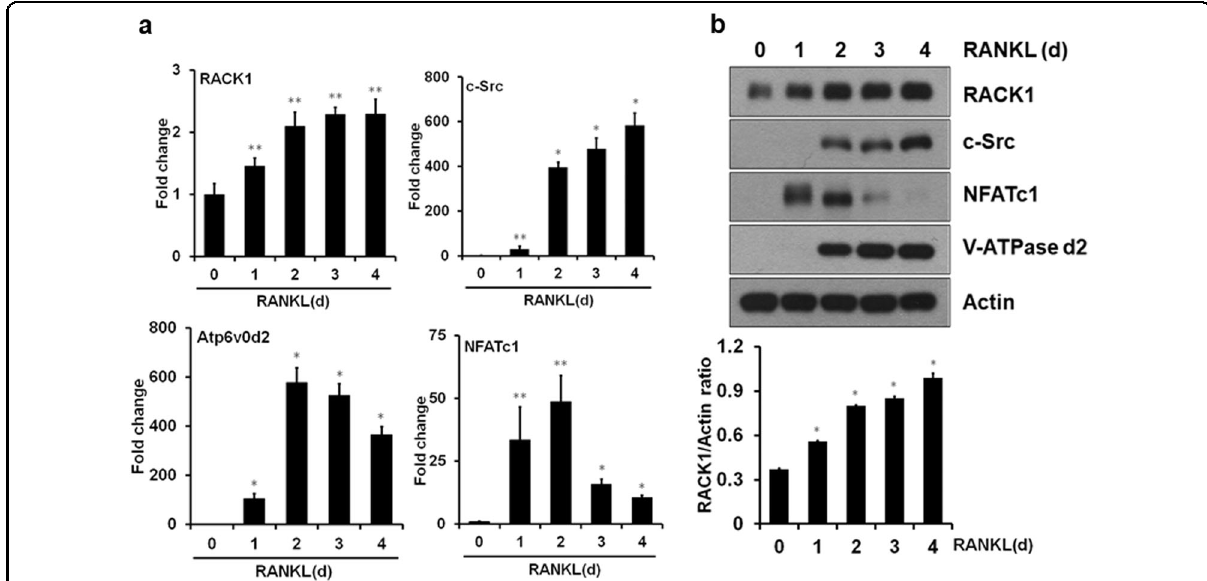
Fig. 1 RACK1 is upregulated during RANKL-induced osteoclastogenesis. Bone marrow-derived macrophages (BMMs) were cultured with 30 ng/ mL M-CSF and 100 ng/mL RANKL for the indicated period of time. a RACK1, c-Src, NFATc1, and V-ATPase d2 mRNA levels were analyzed using real- time PCR. Data are presented as the mean ± SD of three independent experiments. * P < 0.01, ** P < 0.05. b RACK1, c-Src, NFATc1, and V-ATPase d2 protein levels in whole cell lysates were analyzed by western blotting with antibodies speci fi c for the indicated proteins. The ratio of RACK1 to actin was quanti fi ed from three independent experiments. * P < 0.01, ** P < 0.05